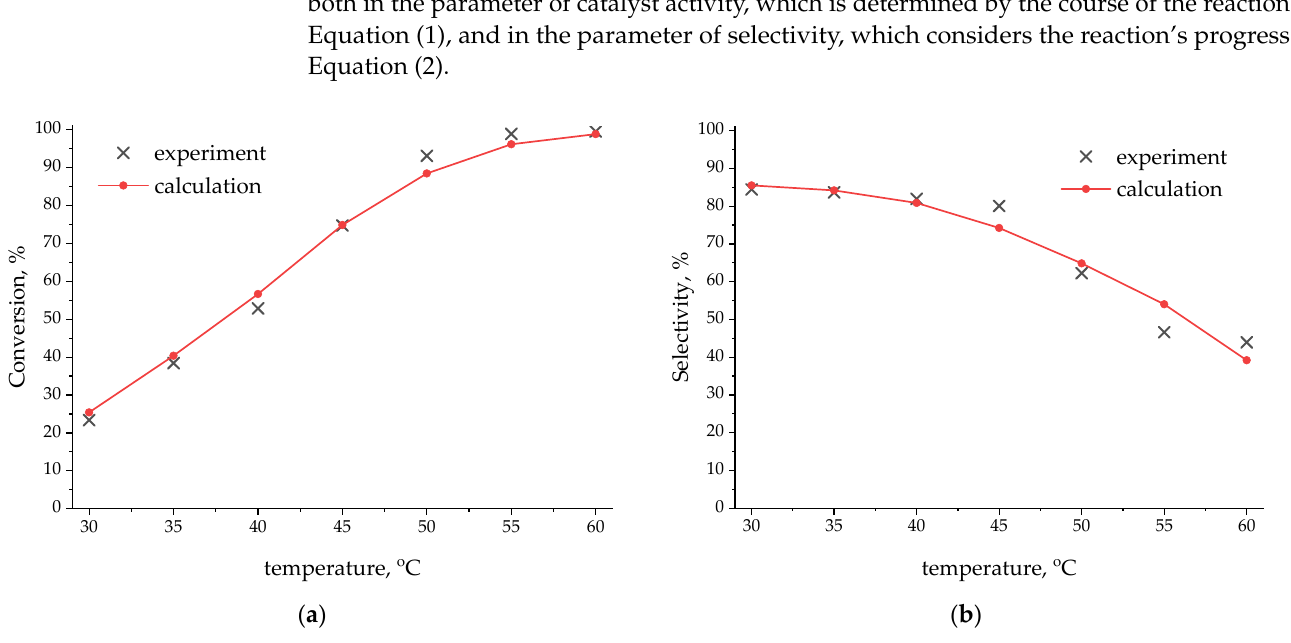
Figure 7. Model verification with experimental data: ( a ) Conversion. ( b ) Selectivity.